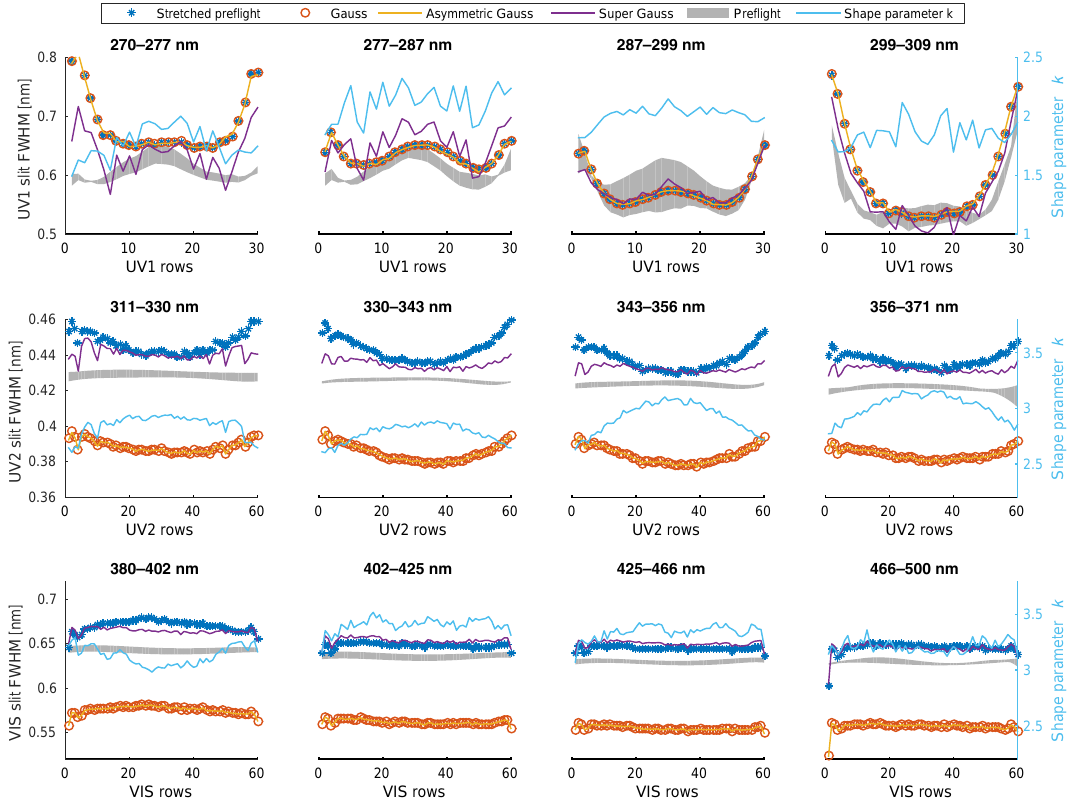
Figure 3. Comparisons of the FWHM of on-orbit slit functions derived from the average OMI irradiance over October 2004–June 2007 with the preflight ones for all three OMI bands, each divided into four fitting windows as shown in Fig. 1. Because the preflight slit functions vary continuously with wavelength, the ranges of preflight slit function FWHM within the spectral window are plotted as the gray bands. The super-Gaussian shape parameter k is shown with vertical axes on the